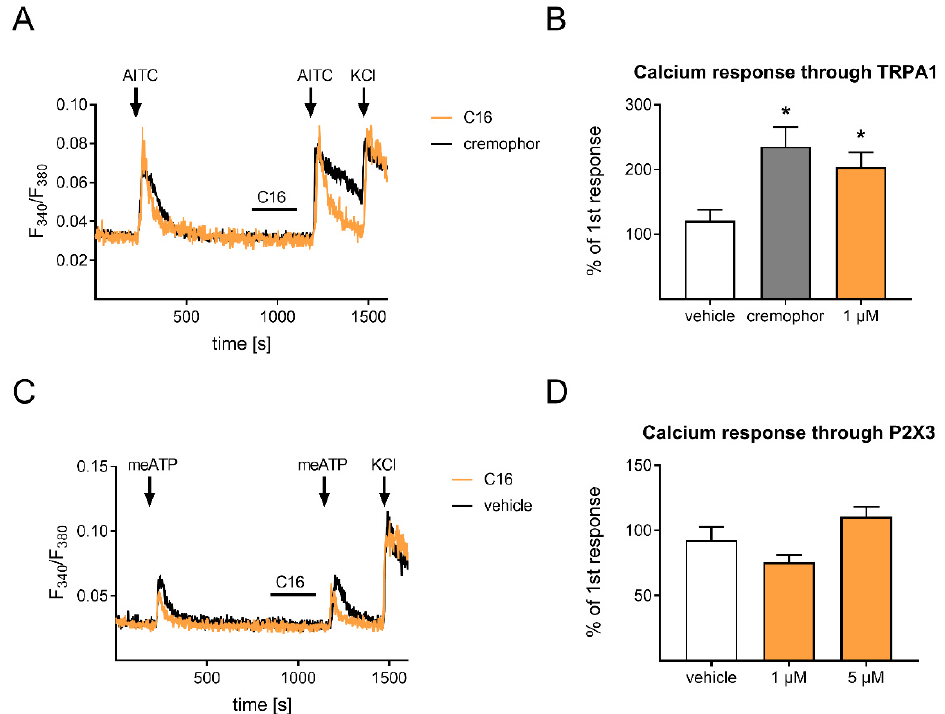
Figure 5. C16 dihydroceramide has no influence on the activity of TRPA1 and P2X3 in primary sensory neurons. ( A ) Representative calcium responses of sensory neurons, which were pre-incubated with C16 (2 min) and stimulated with the TRPA1 agonist AITC (100 µ M, 45 s) followed by a KCl (50 mM) treatment as a positive control. ( B ) Quantification of the two calcium responses in ( A ) after AITC stimulation (untreated and C16 treated). ( C ) Representative calcium responses of sensory neurons, which were pre-incubated with C16 (2 min) and stimulated with the P2X3 agonist meATP (50 µ M, 30 s) followed by a KCl (50 mM) treatment as a positive control. ( D ) Quantification of the two calcium responses in (C) after meATP stimulation (untreated and C16 treated). ( B , D ) The data represents the mean ± SEM of 23–30 sensory neurons per group. * p < 0.05, as per one-way ANOVA with a Tukey’s post-hoc test. Abbreviations: TRPA1: transient receptor potential cation channel subfamily A member 1; AITC: allyl isothiocyanate; meATP: α , β -methyleneadenosine 5 ′ triphosphate trisodium salt; KCl: potassium chloride.